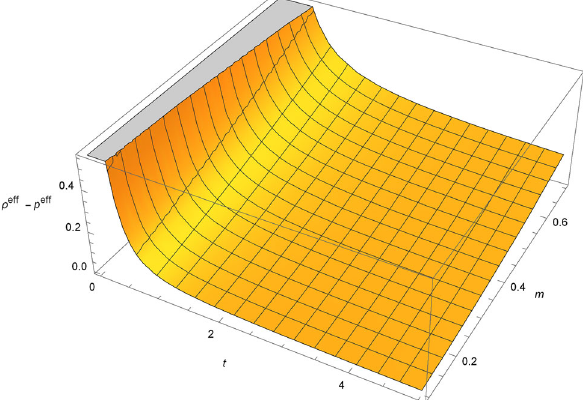
Fig. 5 ρ eff − p eff vs. t , with n = 0 . 6